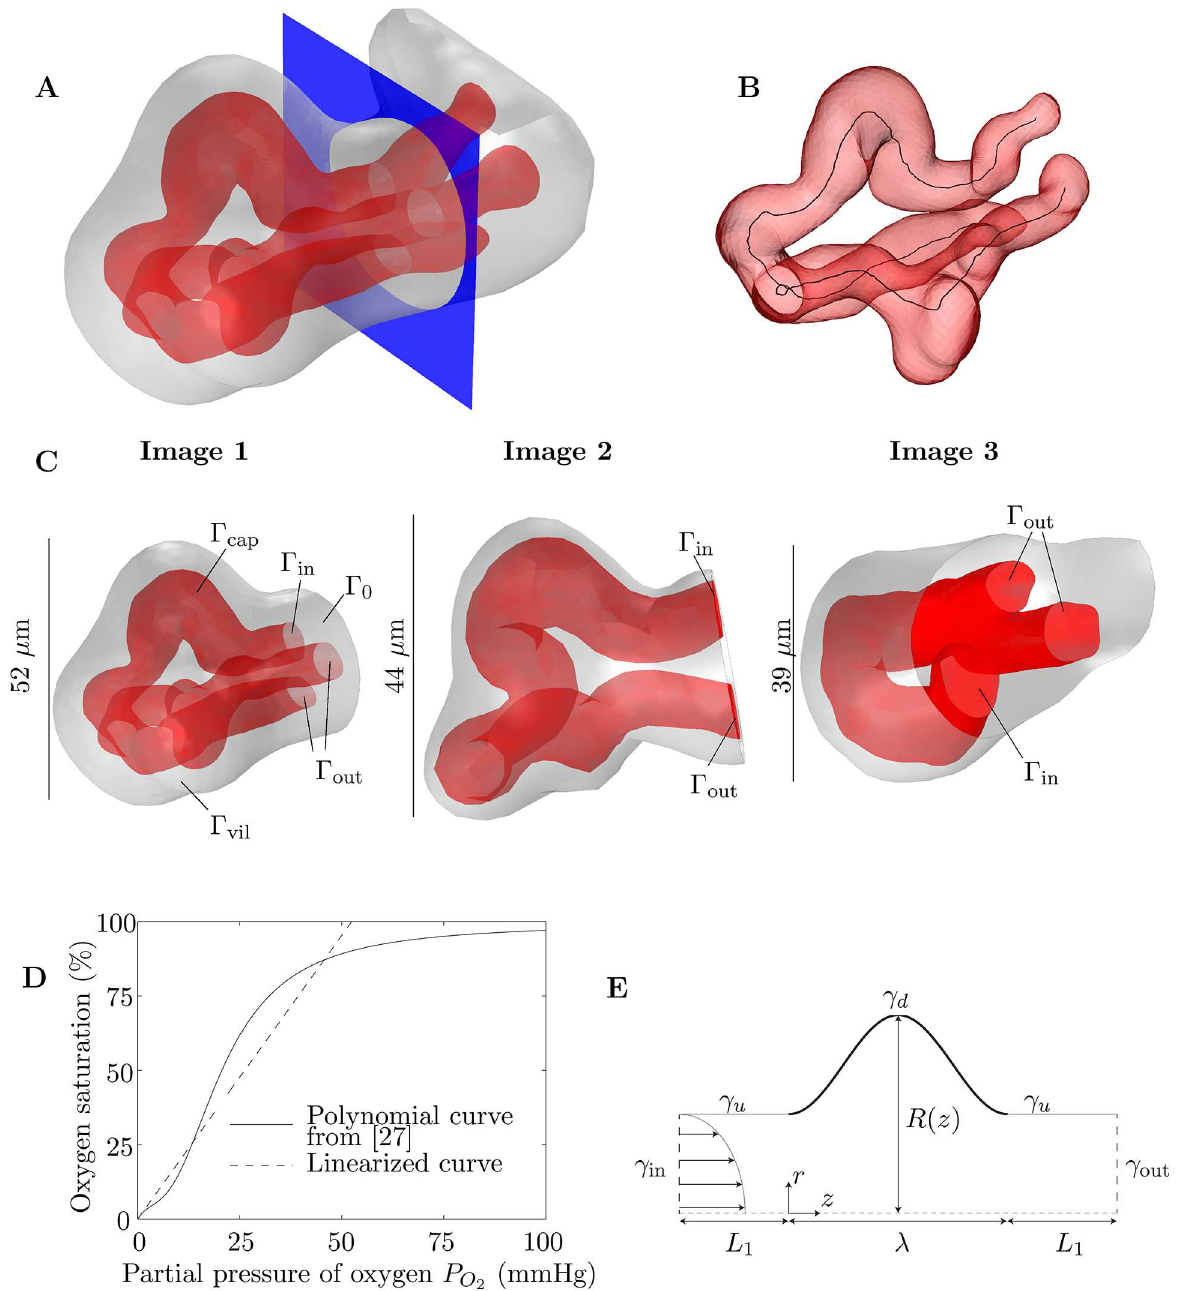
Fig 1. Methods. (A) An example of how 3D images are partitioned with a plane (shown in blue) to provide a surface for boundary conditionsto be applied. The red surface represents the capillary surface (endothelium, Γ cap ) and the grey surface represents the villous surface Γ vil . In this example the capillary bifurcates within the villous branch. (B) Example of the skeletonization of a capillary from a 3D image. The skeletonization line, representingthe centrelineof the lumen, is shown in black. (C) The 3D images of fetal capillariesand villous surfaces used in the simulations (see S1 Images). The images shown have been partitionedby a plane on which boundary conditions are applied,for inflow ( Γ in ), outflow ( Γ out ) and villous tissue ( Γ 0 ). (D) Polynomialfetal oxygen–hemoglobin dissociationlaw from [27] (solid line) and the linear approximation between 0 and 60 mmHg, passing through the origin, found using a least-squares fit (dashed line). The gradient of the linear approximation is K = 0.019 mmHg − 1 . (E) Schematic diagram of the idealized axisymmetric model of a fetal capillary dilation, showingan axisymmetric tube with a localizeddilation. Blood flows into the capillary through γ in and leaves through γ out . Oxygen is provided along the dilated section of the capillary γ d , denoted by the thicker black line. The undilatedsections of the capillary are labeled γ u .